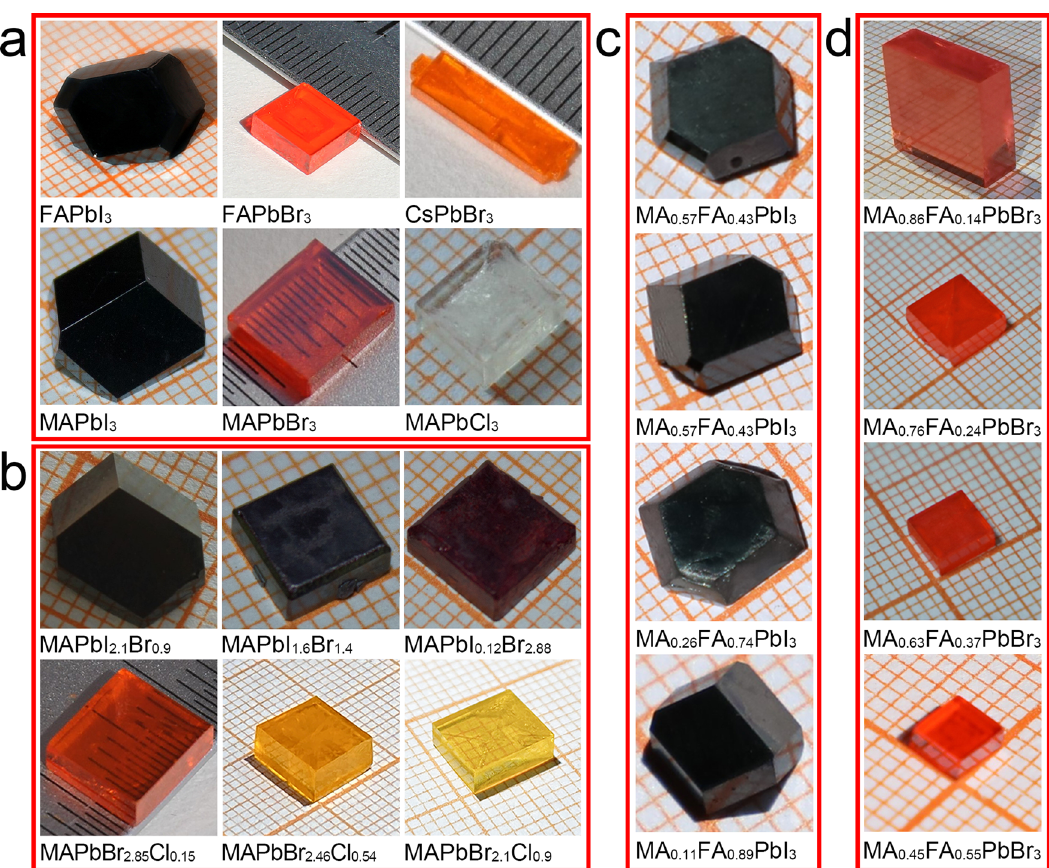
Fig. 1 Photos of OIHPs single crystals. a FAPbX 3 (X = I, Br), CsPbBr 3 , and MAPbX 3 (X = I, Br, Cl) single crystals. b A series of mixed-halide MAPbI x Br 3 − x and MAPbBr x Cl 3 − x single crystals (0 ≤ x ≤ 3). c , d The mixed-organic cation MA y FA 1 − y PbX 3 (X = I, Br) single crystals (0 ≤ y ≤